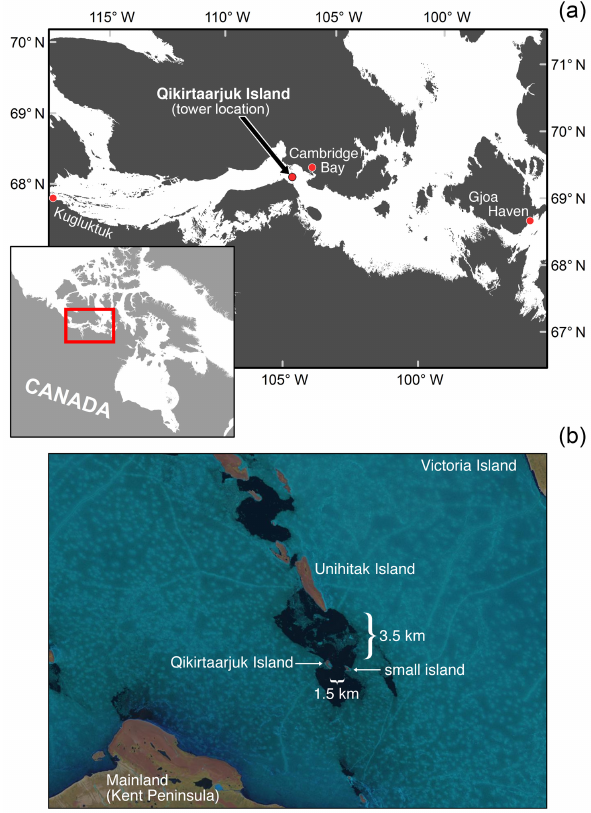
Figure 1. Map (a) showing the location of Qikirtaarjuk Island, 35km west of Cambridge Bay, Nunavut. Satellite image (b) of Qikirtaarjuk Island (28 June 2017), showing polynya development in the tidal straits. Landsat-8 image courtesy of the U.S. Geological